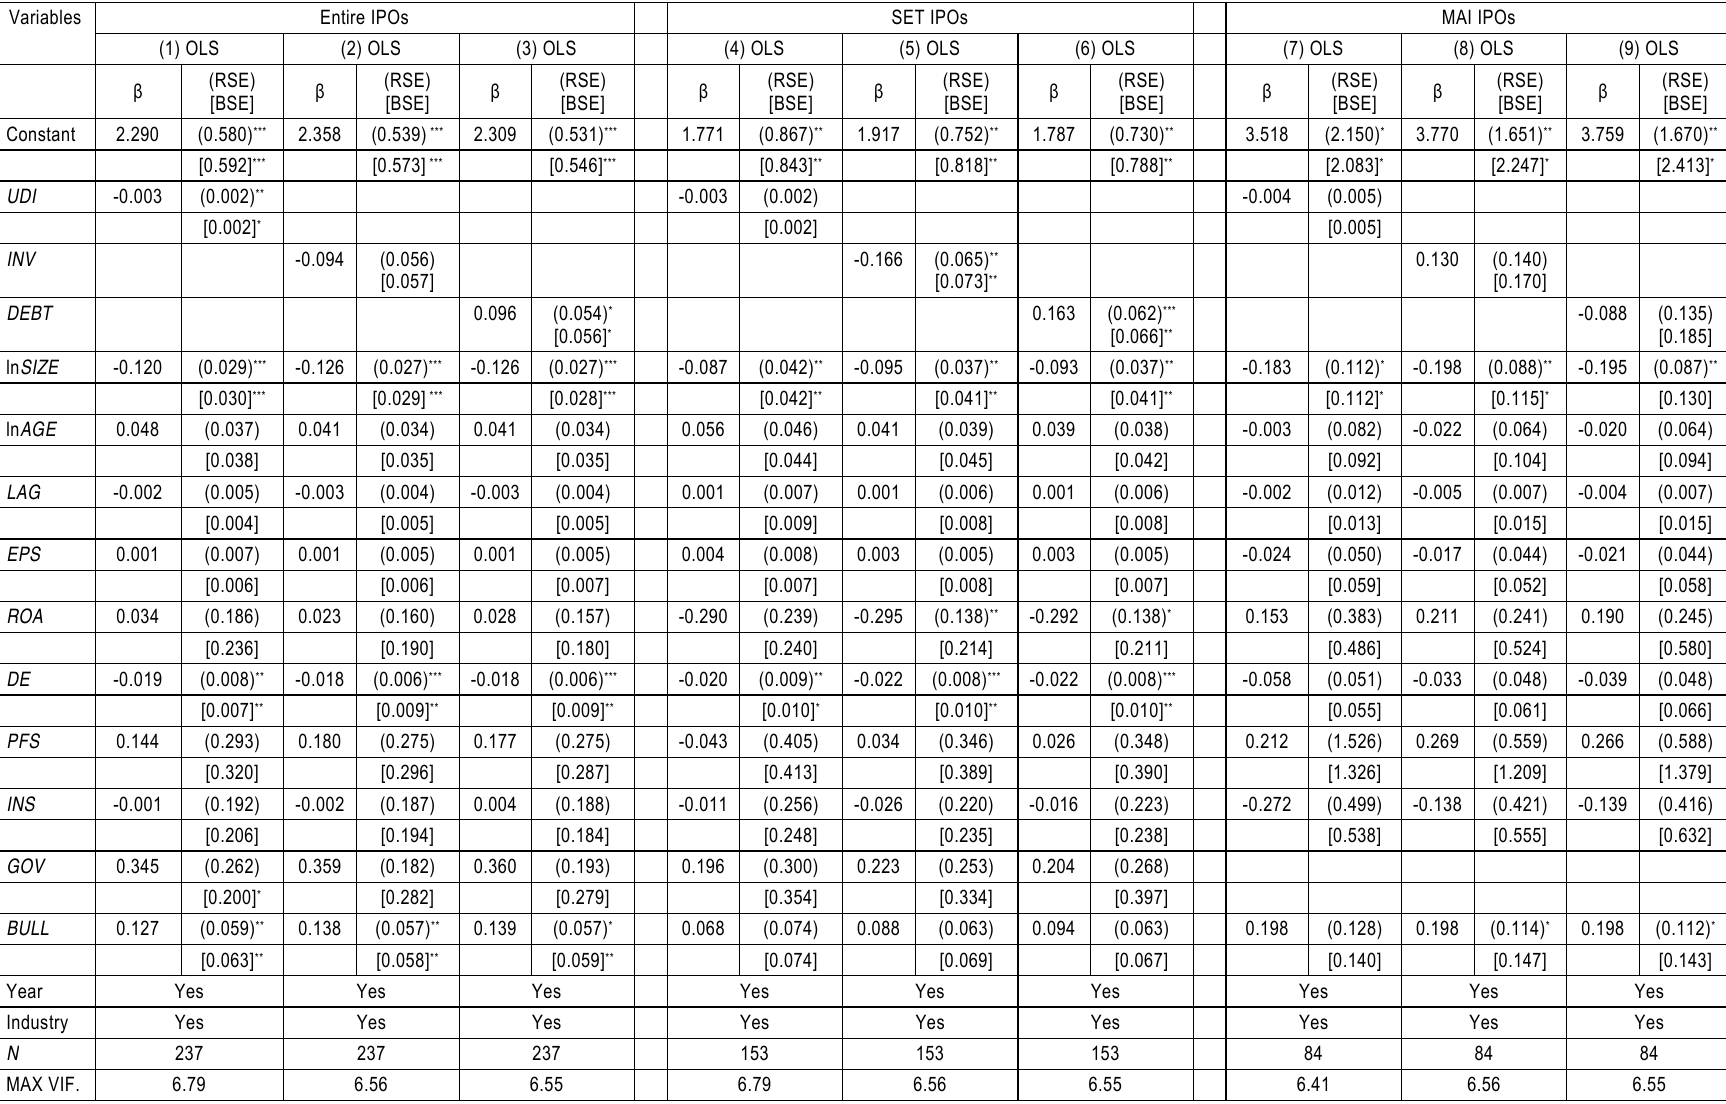
Table 6. OLS Estimates-Robust and Bootstrap Standard Errors